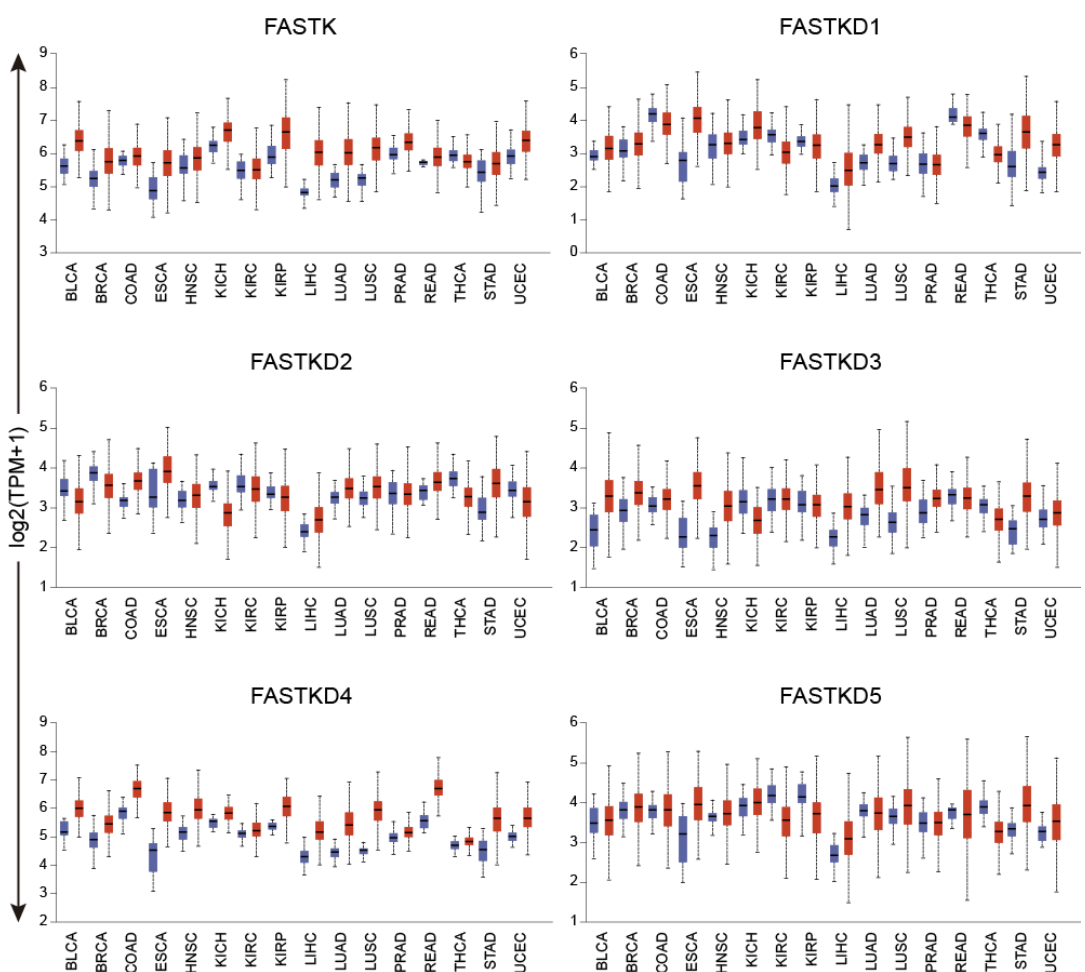
Figure 3. Expression of FASTK genes across human cancers. Boxplots showing the expression of all FASTK genes across 16 cancer types (red) and matched normal tissues (blue). The X-axes represent the name of each type of cancer, while the Y-axes represent the gene expression values as log2 (TMP + 1). p values are provided in Table S3. Figures were generated with the UALCAN online